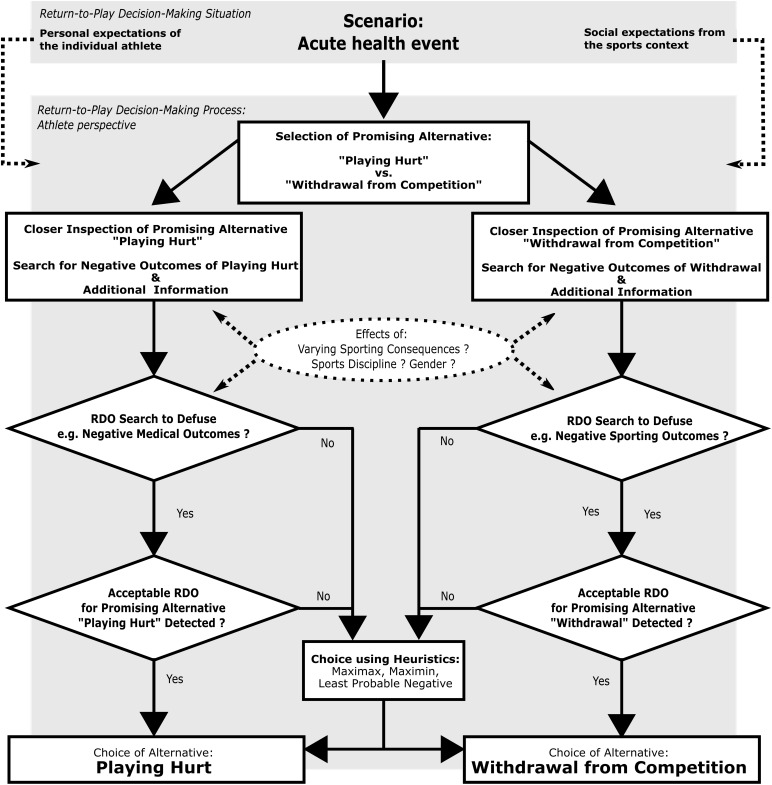
Process model for understanding return-to-play decision making from the athletes’ perspective following Risk Management Decision Theory (Huber, 2012).